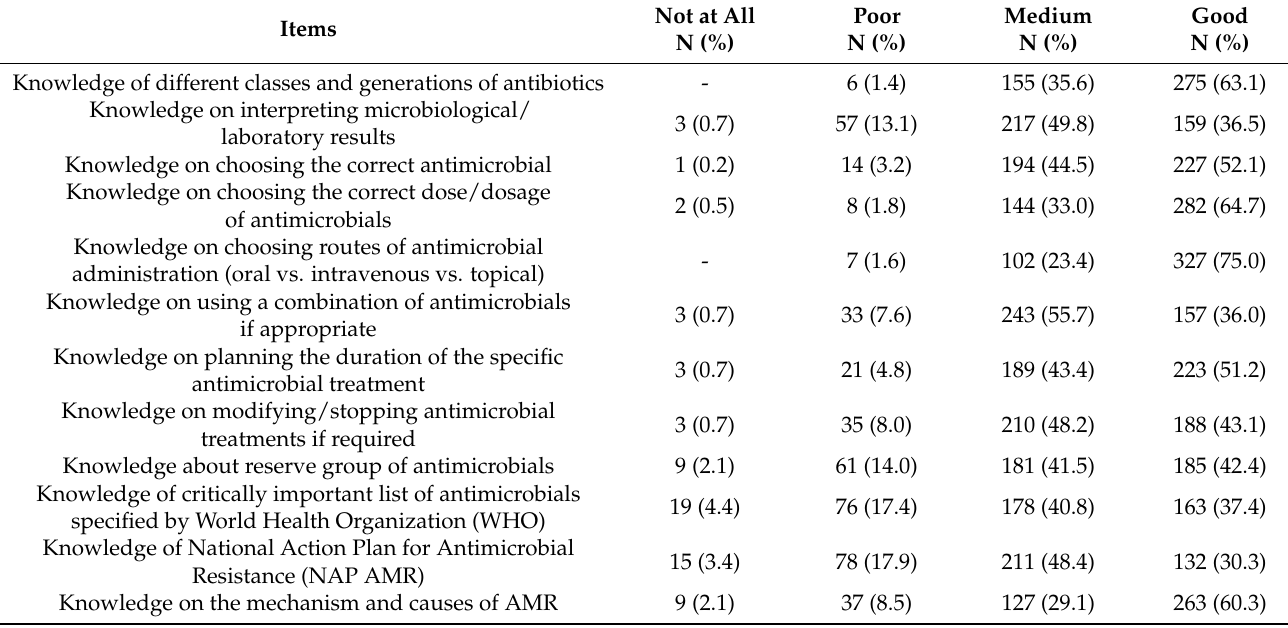
Table 2. Knowledge of veterinarians on AMU and